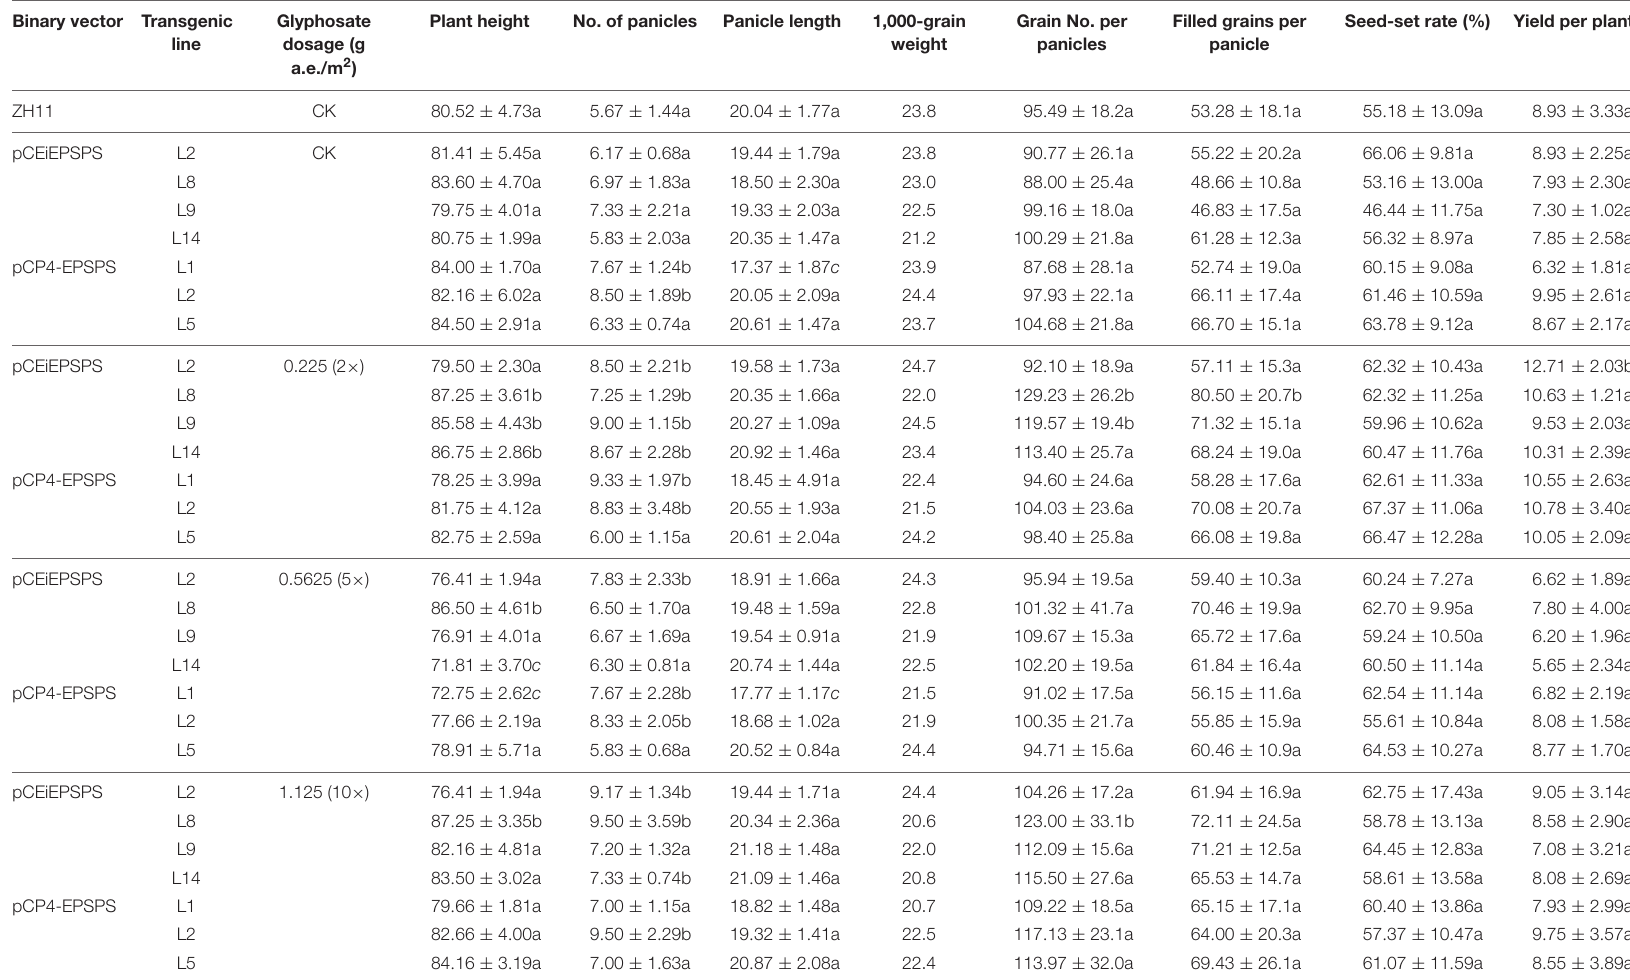
TABLE 4 | Glyphosate resistance analysis of the T 1 transgenic lines in the field. Binary vector Transgenic